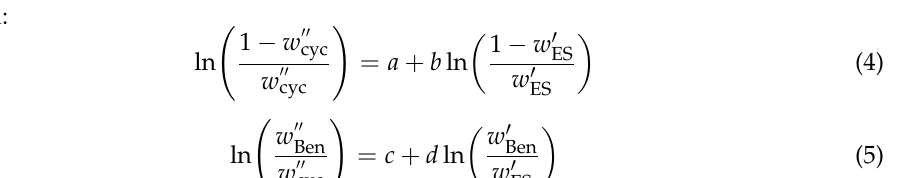
Figure 7. Variation of the distribution ratio and selectivity with benzene weight fraction in the feed for [Benzene (1) + Cyclohexane (2) + TBPB:PTSA (1:1) (3)].